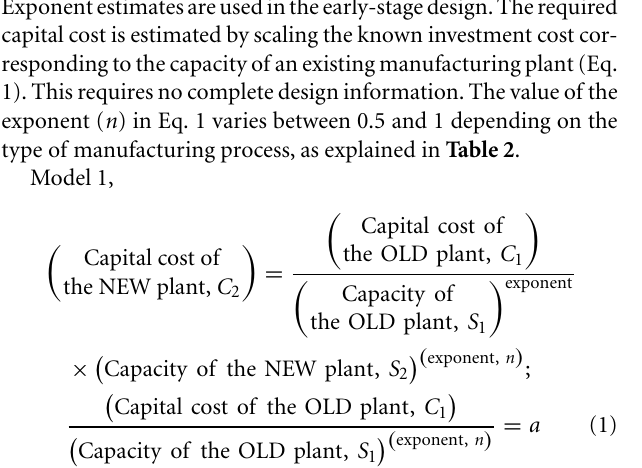
Model 1: order-of-magnitude estimates (production rate and investment of the existing plant)